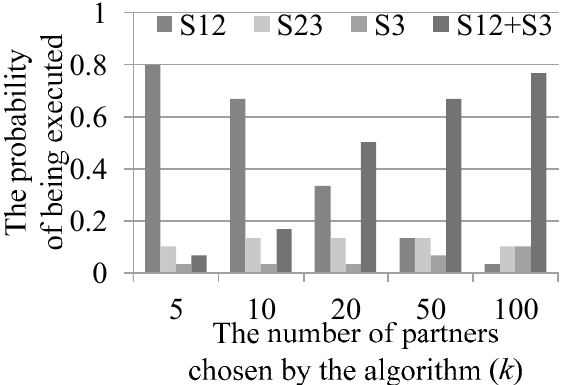
Figure 9. Probability of each strategy combination being executed.